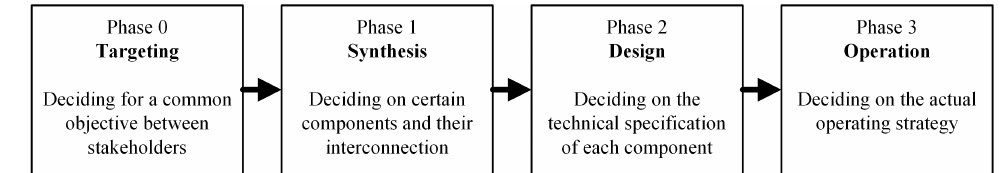
Figure 1. Presentation of the successive planning processes for designing an energy supply solution in complex actor structures. The phases are run through one after the other with the participation of various stakeholders. Each phase involves important decisions that will have a significant impact on the results of the next